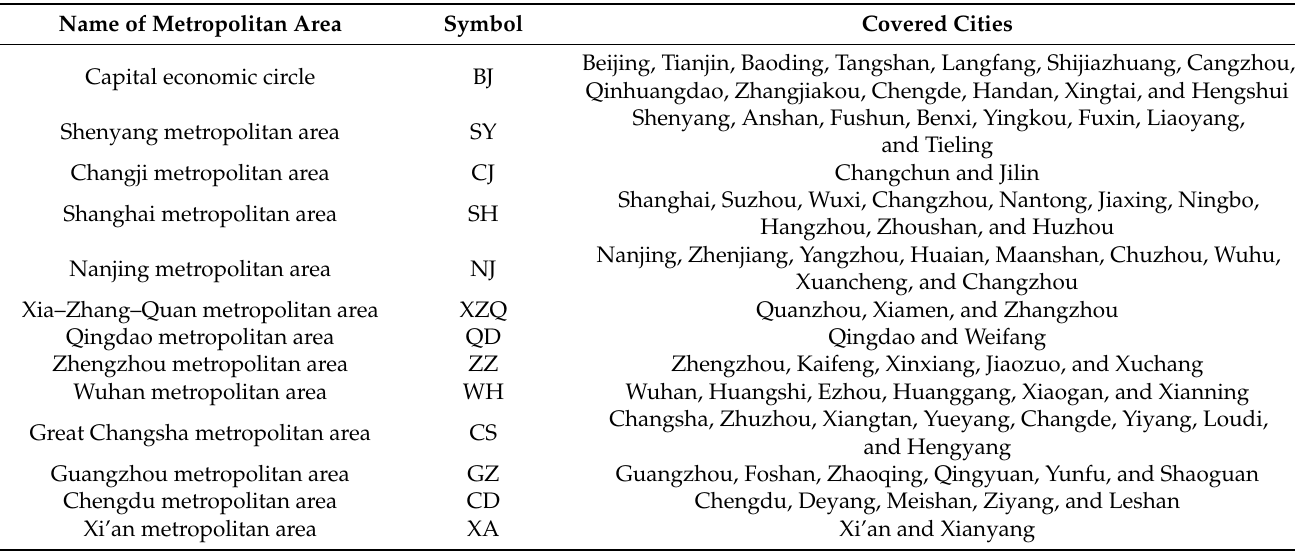
Table 2. Description of metropolitan areas and their covered